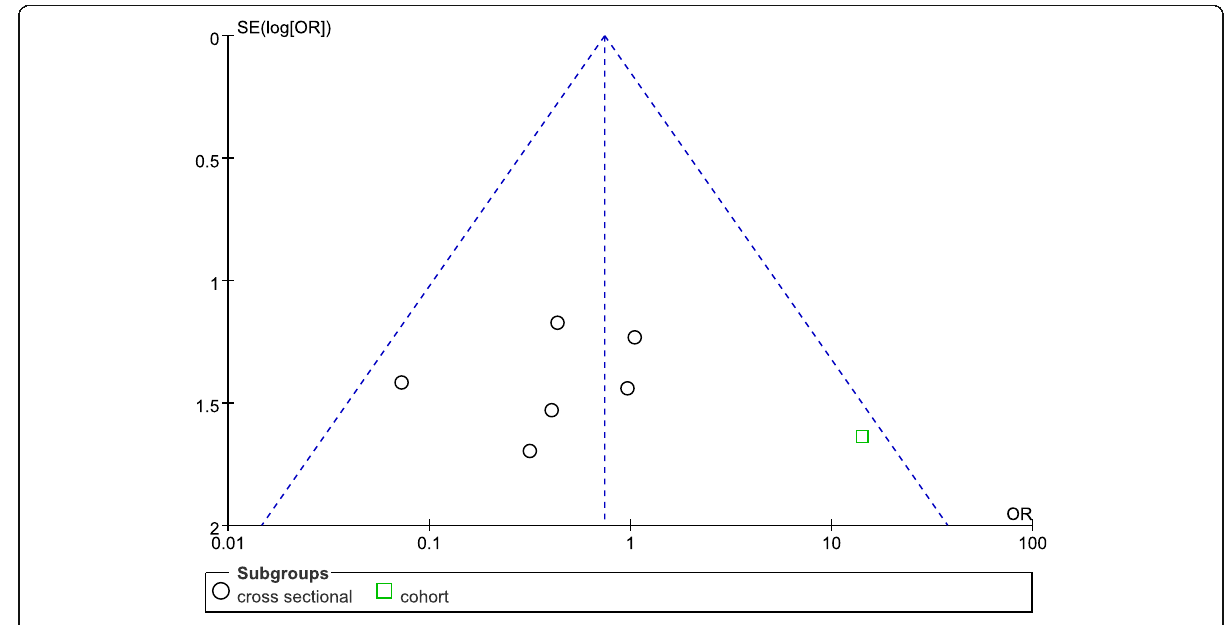
Fig. 5 Funnel plot of the survival rate during the healing period between short implants combined with TSFE (experimental group) and conventional implants combined with TSFE (control